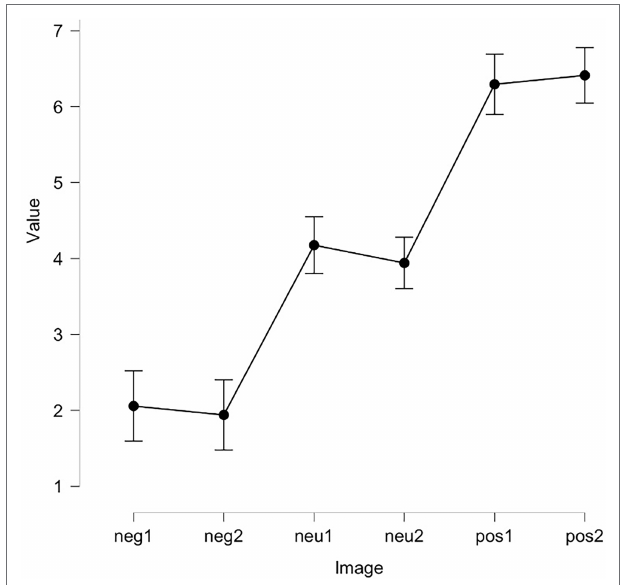
FIGURE 4 | Valence values of images from Experiment